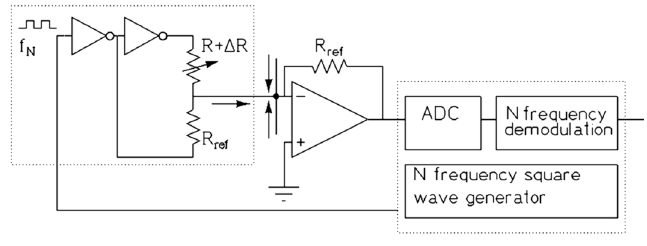
Figure 2. Practical system architecture with binary modulation and signal processing components.